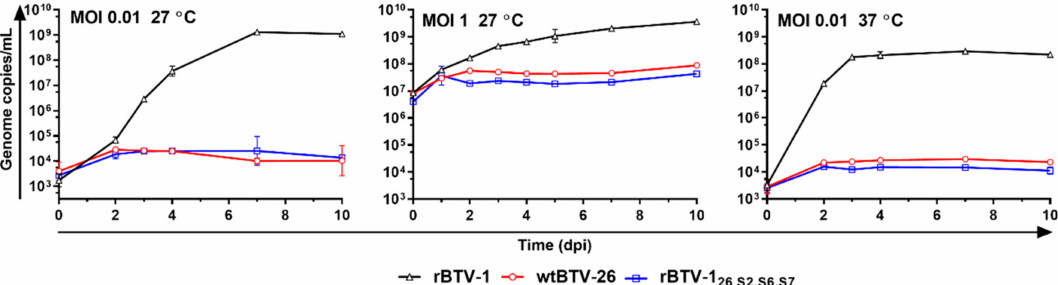
Figure 4. Replication kinetics of rBTV-1, BTV-26 and rBTV-1 26 S2,S6,S7 in Culicoides cells under several conditions. KC cells were seeded at a density of 7.00 × 10 5 cells/well on coverslips, and infected at a MOI of 0.01 or 1, with rBTV-1 (black triangles), BTV-26 (red circles) or rBTV-1 26 S2,S6,S7 (blue squares). Infected cells were incubated at +27 ◦ C or 37 ◦ C without CO 2 . Two hundred and fifty µ L of supernatant were collected at each indicated time point, and total RNA extracted from 100 µ L of supernatant. BTV genome copy numbers were determined using the qRT-PCR BTV Seg-9 assay [50]. Results are expressed as the mean of genome copies/mL of two independent experiments ± standard error of the